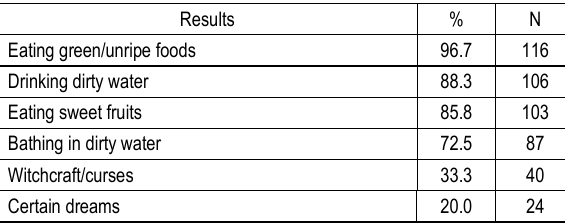
Table 2. Causes of malaria other than